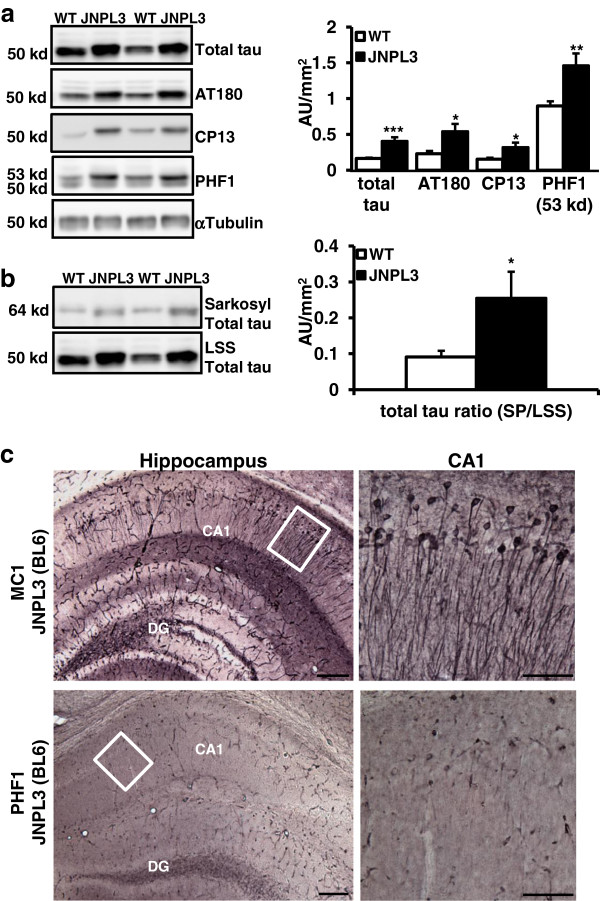
Aged JNPL3 (BL6) mice show increased tau pathology in the cortex and hippocampus. (a) Western blot analysis of total tau levels and phospho-tau status in low speed supernatant (LSS) fractions. Total tau levels were significantly increased in Tg mice compared to age-matched WT mice (n=14 per group, t26=4.616, ***P=0.0002). Early-stage pathological phospho-tau markers, AT180 and CP13, were also significantly increased in cortical tissue from Tg mice (AT180: t26=3.674, *P=0.0011; CP13: t26=2.156, *P=0.0405). Immunoblotting with the PHF1 antibody showed a significant shift in the banding pattern from 50 kd to 53 kd in Tg mice when compared to WT controls (t26=2.527, *P=0.0179). (b) Levels of insoluble sarkosyl pellet tau normalized to LSS total tau are increased in Tg mice compared to controls (t26=2.215, *P=0.0357). (c) Tg mice showed positive immunostaining with pathological-tau MC1 and PHF1 antibodies. Both antibodies showed staining in the CA1 of JNPL3 (BL6) mice, although to a lesser extent for the PHF1 than MC1 antibody. Inset is higher magnification of the highlighted area. Since brains were fixed with paraformaldehyde without perfusing, blood vessel staining was also present (DG=dentate gyrus, CA1= hippocampal area CA1; Scale bar = 200 μm). Data presented as mean + SEM.